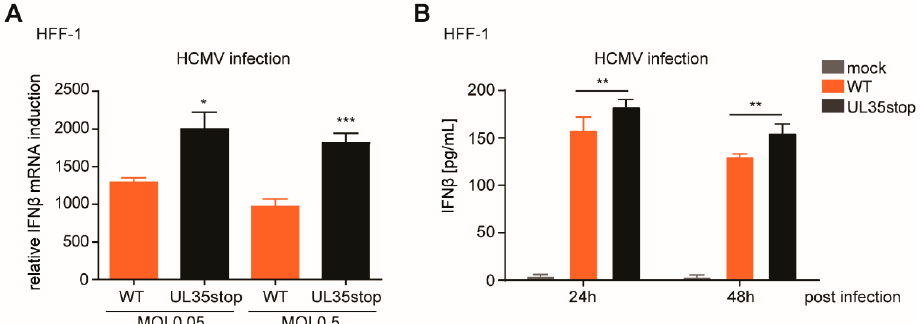
Figure 4. UL35 negatively modulates the type I IFN response upon HCMV infection. ( A ) HFF-1 were mock treated or infected with either HCMV WT or UL35stop at an MOI of 0.05 or 0.5. RNA was extracted 6 h post infection and the relative expression of IFN β mRNA normalized to HPRT1 was quantified by RT-qPCR. ( B ) HFF-1 were mock infected or infected with either HCMV WT or UL35stop at an MOI of 0.5. Supernatants were harvested at the indicated time points and used for quantification of secreted IFN β by MSD Multiplex assay. ( A-B ) Shown is combined data of three independent experiments as mean ± SD. Student’s t -test (unpaired, two tailed) was applied to compare HCMV WT and UL35stop. * p < 0.05, ** p < 0.01, *** p < 0.001.